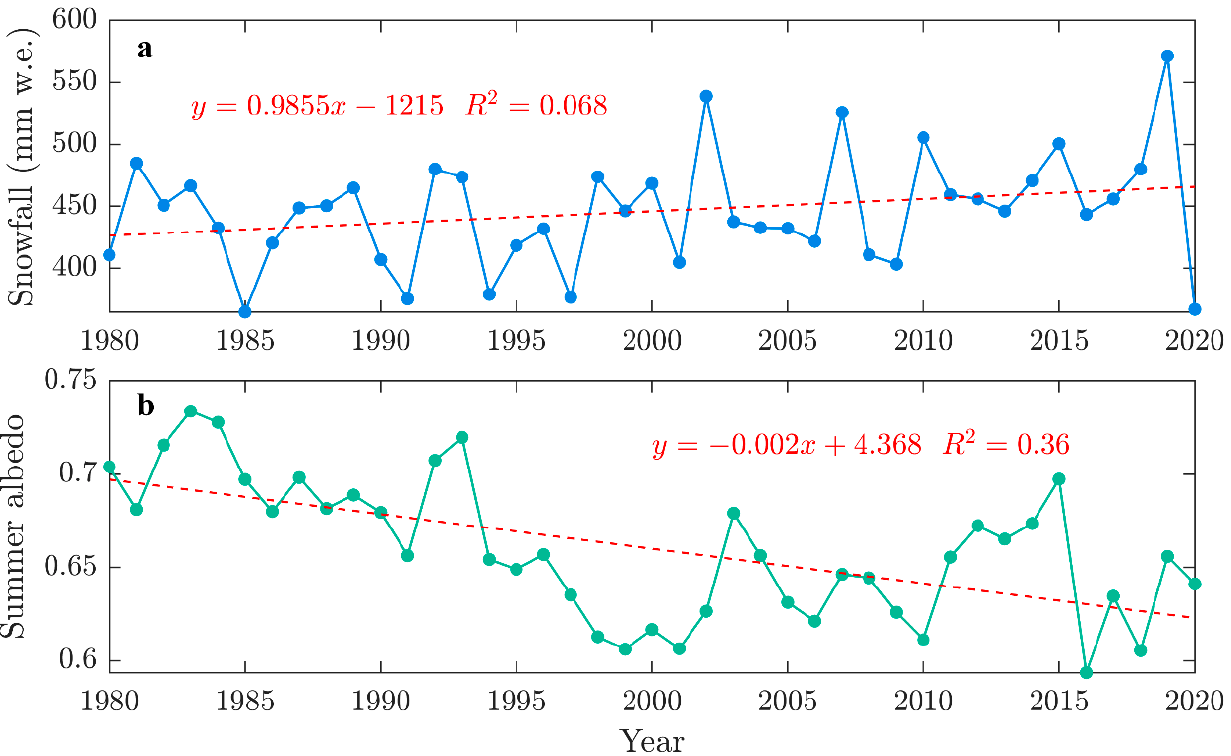
Figure 9. Changes of snowfall ( a ) and summer albedo ( b ) during the study period. To explore the response of MB to climate change, we set up different scenarios of independent changes in temperature, precipitation and incoming shortwave radiation. Changes in temperature from − 2 to +2 ◦ C with a step of 0.5 ◦ C were observed, and the precipitation and incoming shortwave radiation changed from − 20% to +20% with a step of 5%. The sensitivity tests of the model parameters are performed by varying one parameter and keeping the others fixed. The sensitivity test results are shown in Figure 10. The MB is more sensitive to the increase in meteorological elements than to the decrease. LHG12 is most sensitive to temperature, followed by incoming shortwave radiation, and finally precipitation. In Figure 10, the MB sensitivity to temperature changes simulated by ETIM was slightly higher than that simulated by SEBM; when the temperature changed by +1 ◦